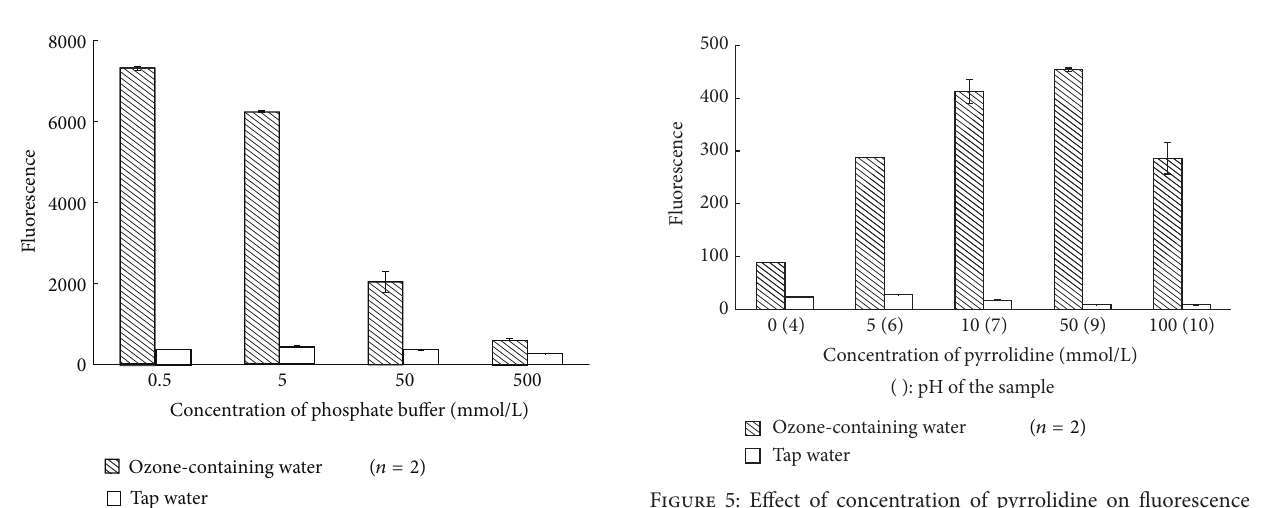
Figure 5: Effect of concentration of pyrrolidine on fluorescence intensity. (): pH for fluorometry.